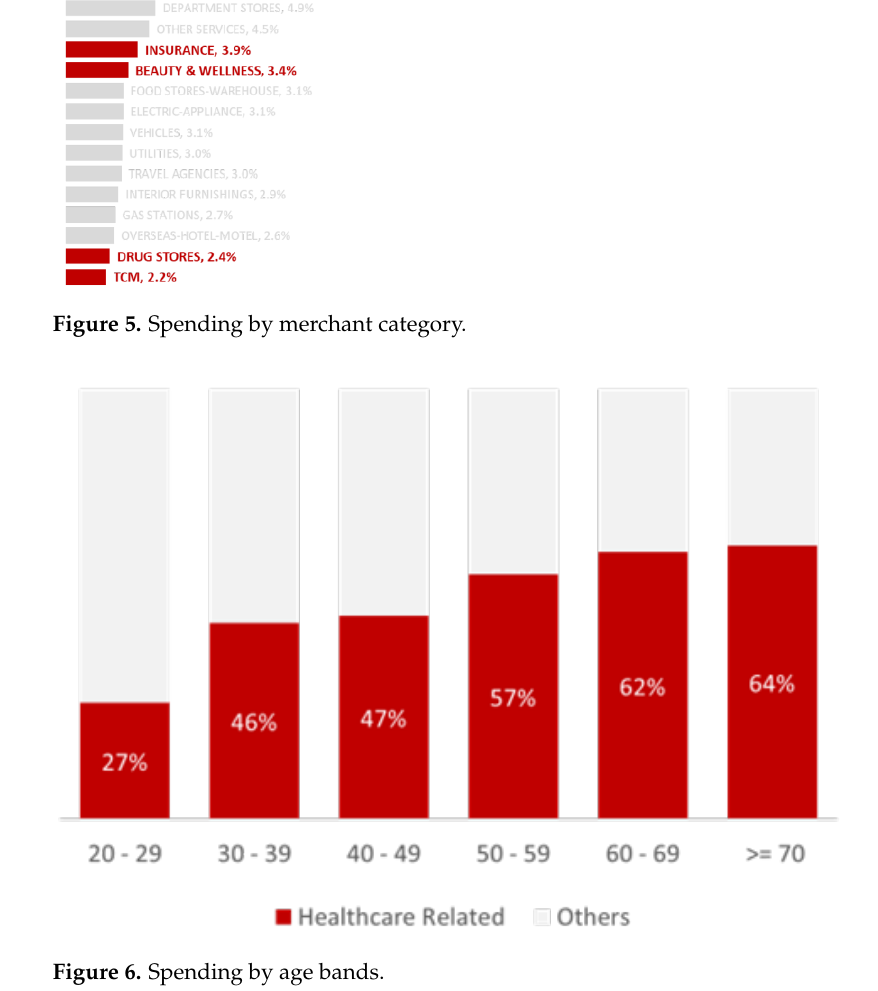
Figure 6. Spending by age bands.